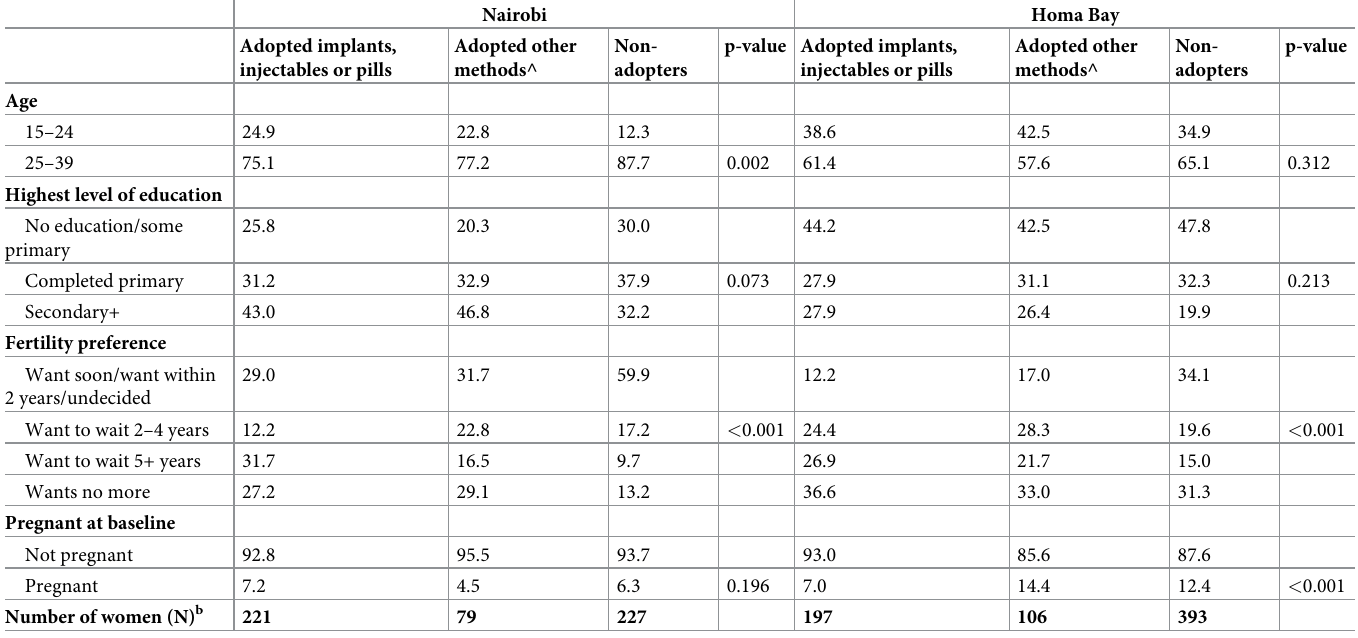
Table 1. Characteristics of married or cohabiting women aged 15–39 years by use status and method choice at follow up among non-users at baseline. Nairobi Homa Bay Adopted implants, injectables or